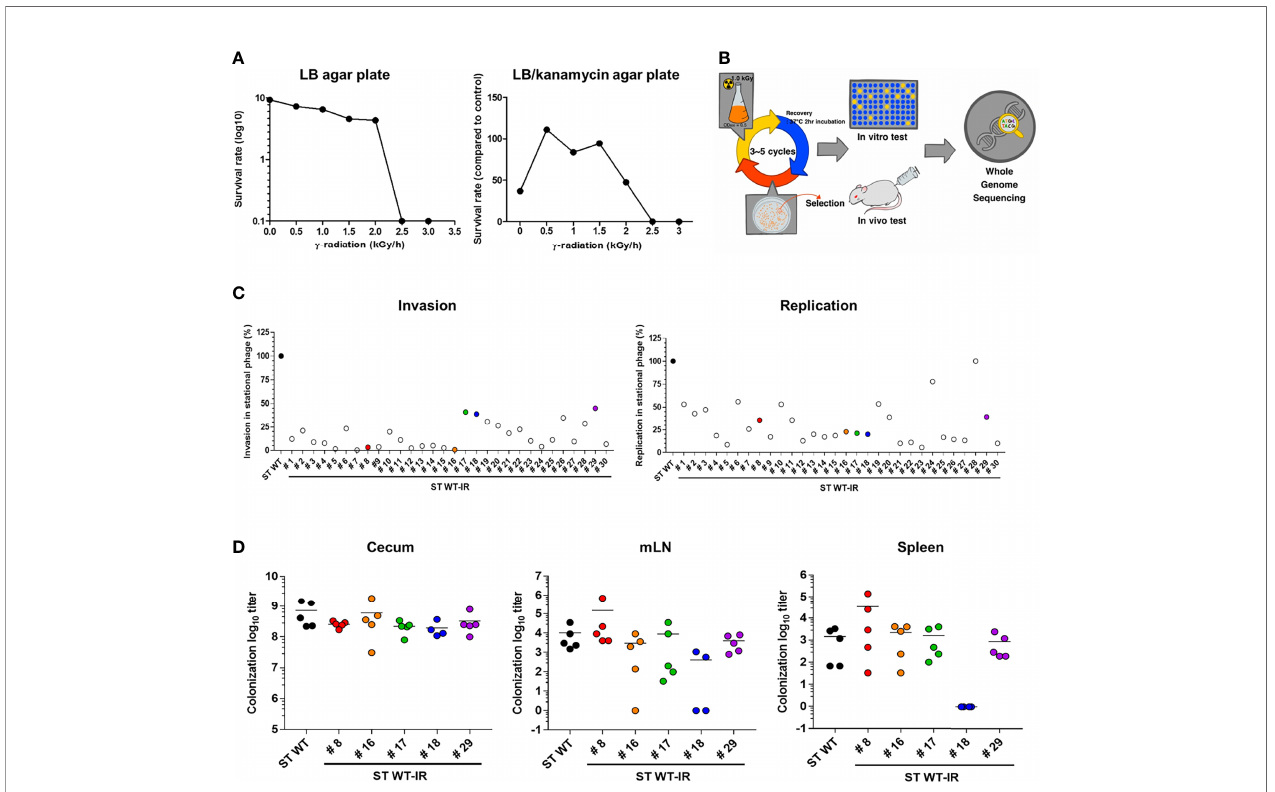
FIGURE 1 | Construction of attenuated Salmonella vaccine strain using radiation mutation enhancement techniques (R-MET). (A) The radiation dose selection for R- MET. ST WT was irradiated with high-dose 60 Co gamma-ray. The ratio of survived/dead bacteria was evaluated by plating on LB plate (left panel) and mutated strains were detected by plating on LB plate with 10 m g kanamycin (right panel). (B) Schematic for developing attenuated Salmonella vaccine strains. (C) In vitro virulence test. Macrophages (RAW 264.7 cells) were infected with ST WT or selected candidates (n=30) at a multiplicity of infection of 10 and bacterial viability was evaluated at 2 h (invasion; left panel) or 18 h (replication; right panel). Relative invasion and replication fold of candidates were calculated by comparing with ST WT. Data are representative of three independent experiments and are presented as the mean ± standard deviation. (D) Salmonella colonization in mice organs. BALB/c mice (n=5) were inoculated orally with 1×10 8 CFU WT and attenuated candidates (8, 16 – 18, 29). At 72 hpi, the number of bacteria in the cecum (left panel), mLN (middle panel), and spleen (right panel) were counted. Data were presented as the mean ± standard deviation. CFU, colony forming unit; WT, wild type; hpi, hours post-infection; mLN, mesenteric lymph